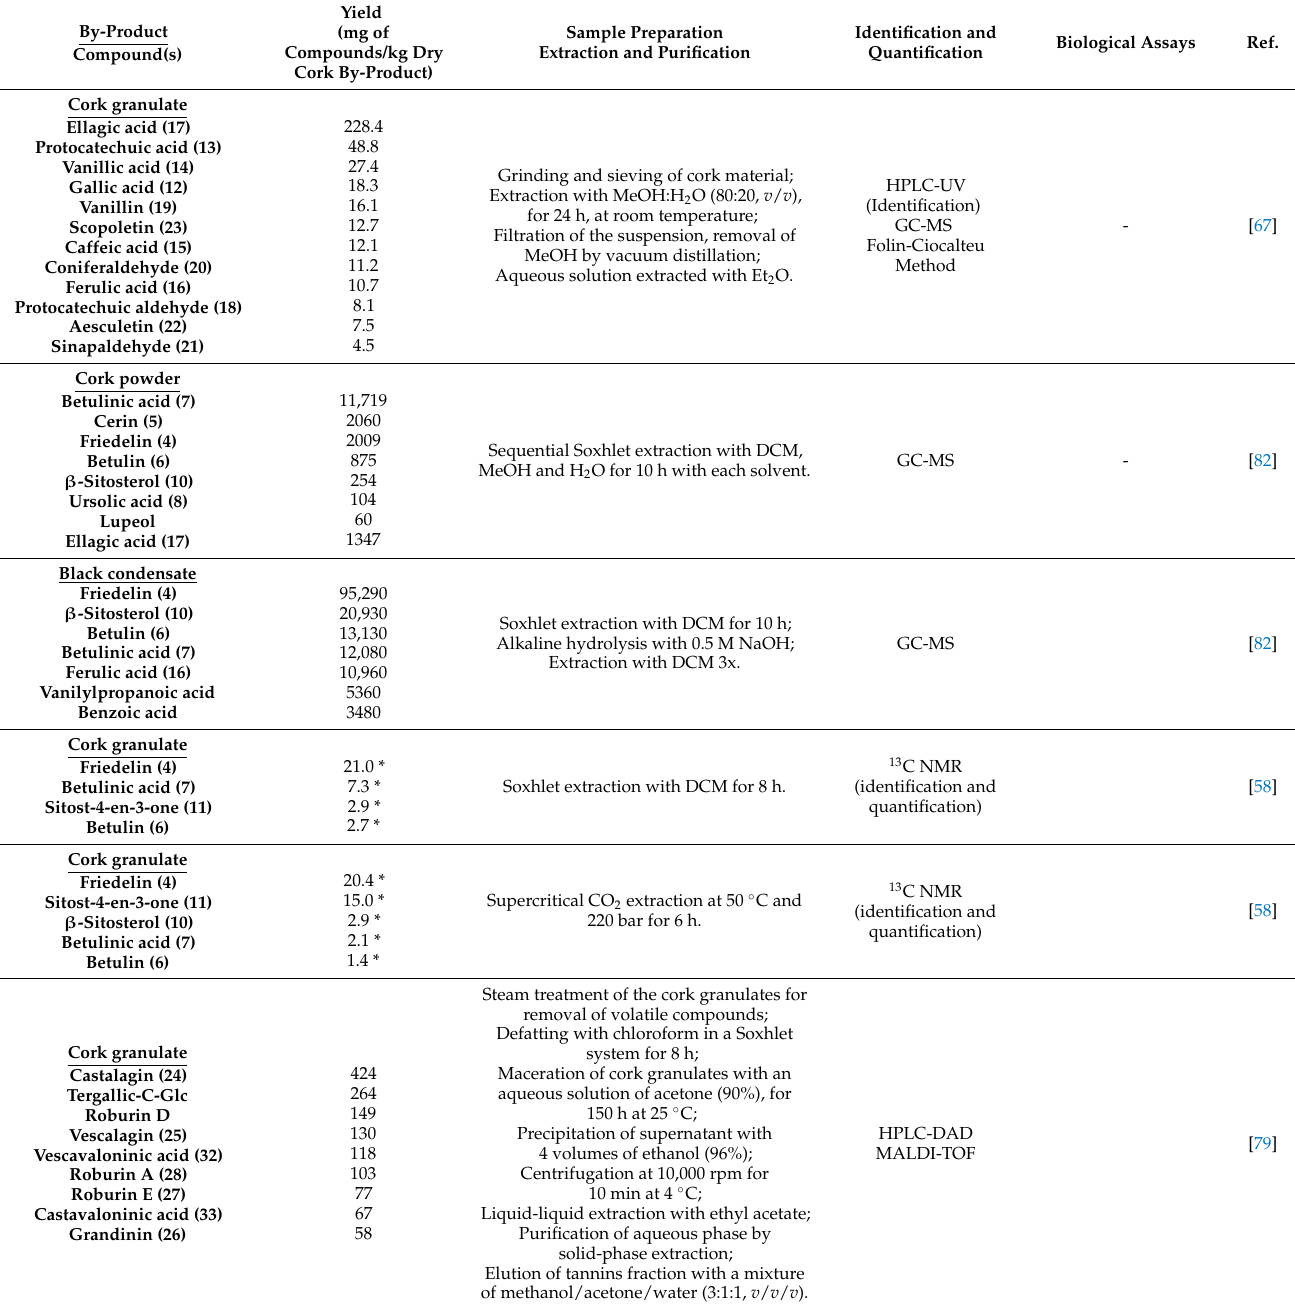
Table 2. Different procedures for the extraction, purification, identification, and quantifica- tion of compounds in cork by-products, as well as biological assays commonly employed for their